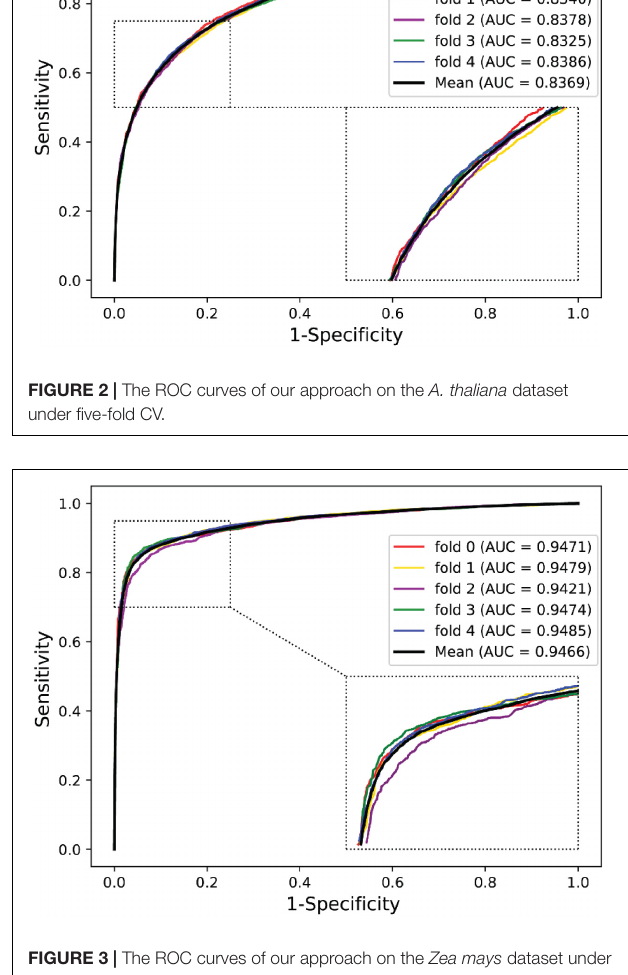
tool for signal analysis in the time and frequency domains.